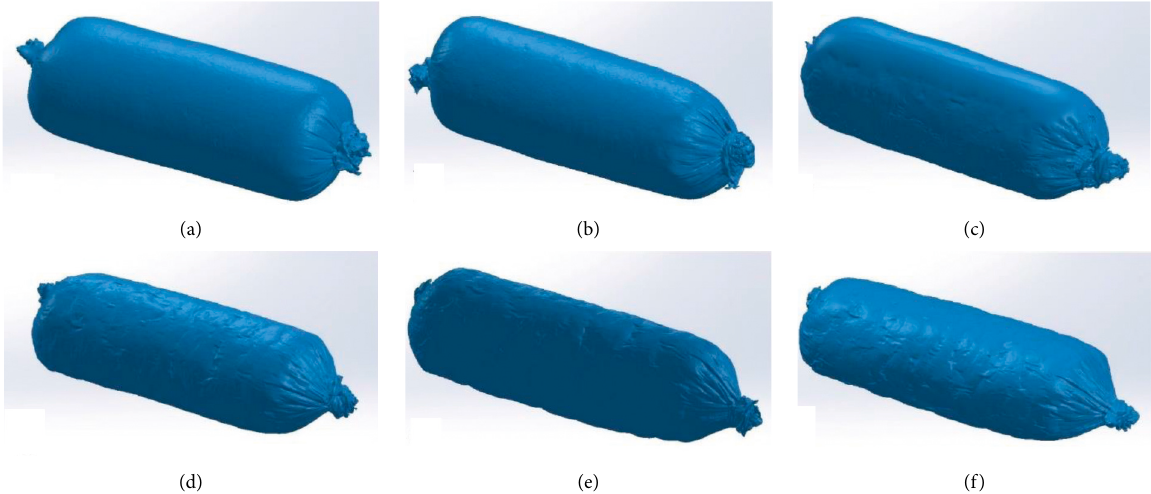
Figure 1: Three-dimensional (3D) models of control (N110) kulen during different stages of ripening: (a) production day, (b) 8th day, (c) 16th day, (d) 24th day, (e) 32th day, and (f) 40 th